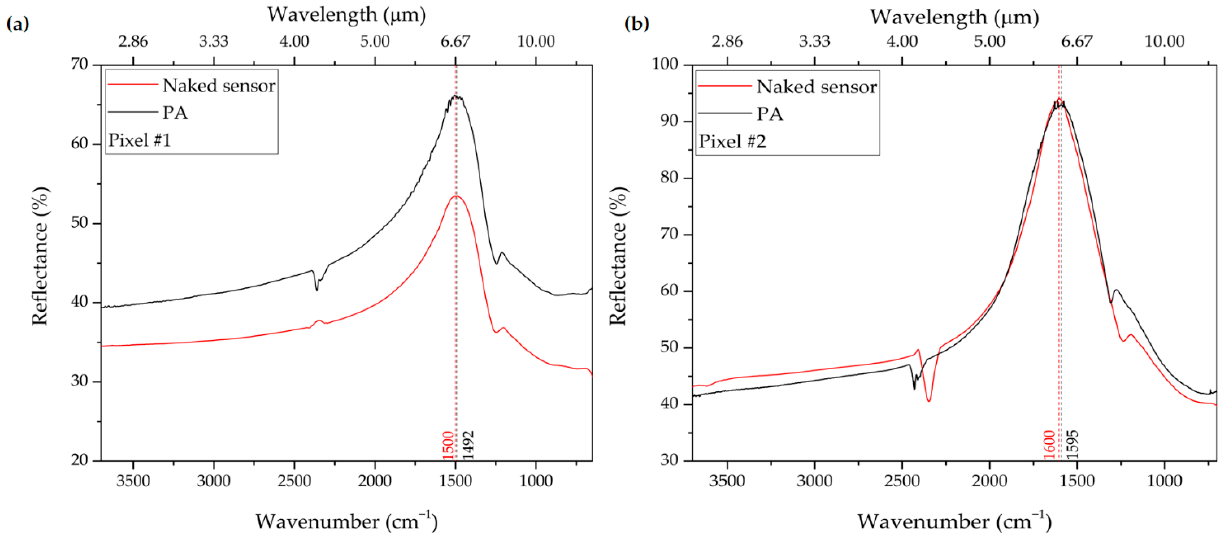
Figure 7. Red ‐ shift of the resonance after the functionalization of ( a ) pixel #1 and ( b ) pixel #2. In this case, due to the PA monolayer linked to the NA surface, we observe a red ‐ shift of 8 cm − 1 for pixel #1 and of 5 cm − 1 for pixel #2. During the functionalization, a molecule of DSP binds to each gold atom exposed on the surface; subsequently, a molecule of PA binds to each molecule of DSP. The SEIRA spectra are acquired on dehydrated protein monolayers.